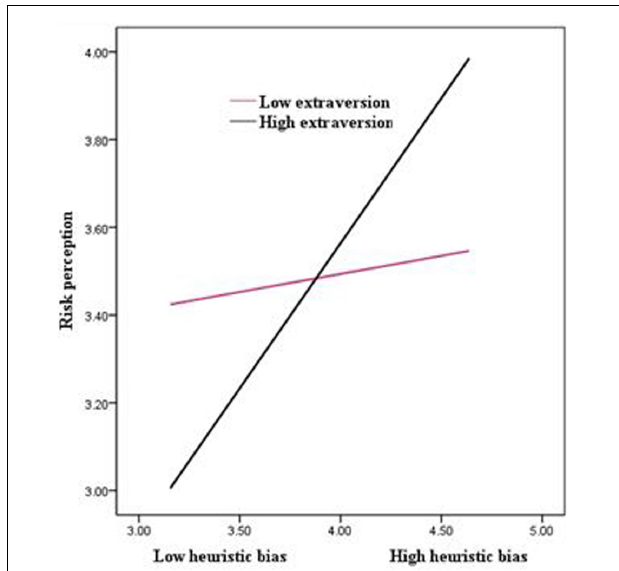
FIGURE 3 | The moderating role of extraversion in the association between heuristic bias and risk perception.